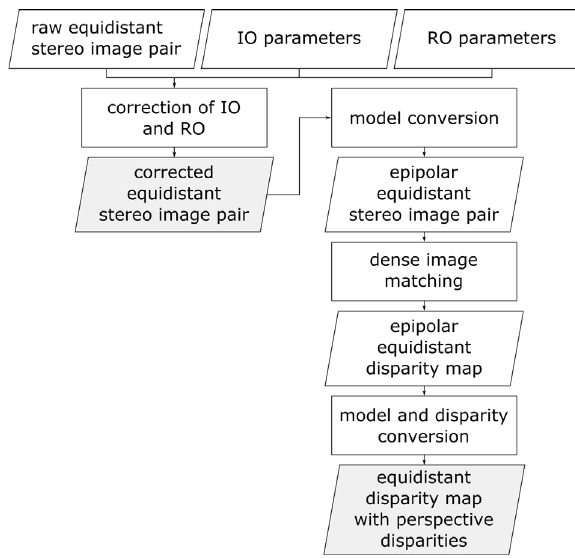
Figure 6. Workflow for fisheye image processing Our workflow for stereo fisheye processing is illustrated in Figure 6. First, interior orientation (IO) and relative orientation (RO) are corrected. Parallel epipolar lines are required for stereo image matching algorithms such as semi-global matching (SGM) (Hirschmüller, 2008) or tSGM (Rothermel et al., 2012). to epipolar equidistant is essential (Abraham & Förstner,